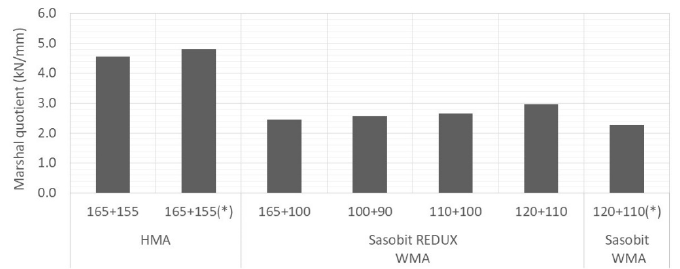
Figure 8. Variation of Marshall flow with mixture and temperature.